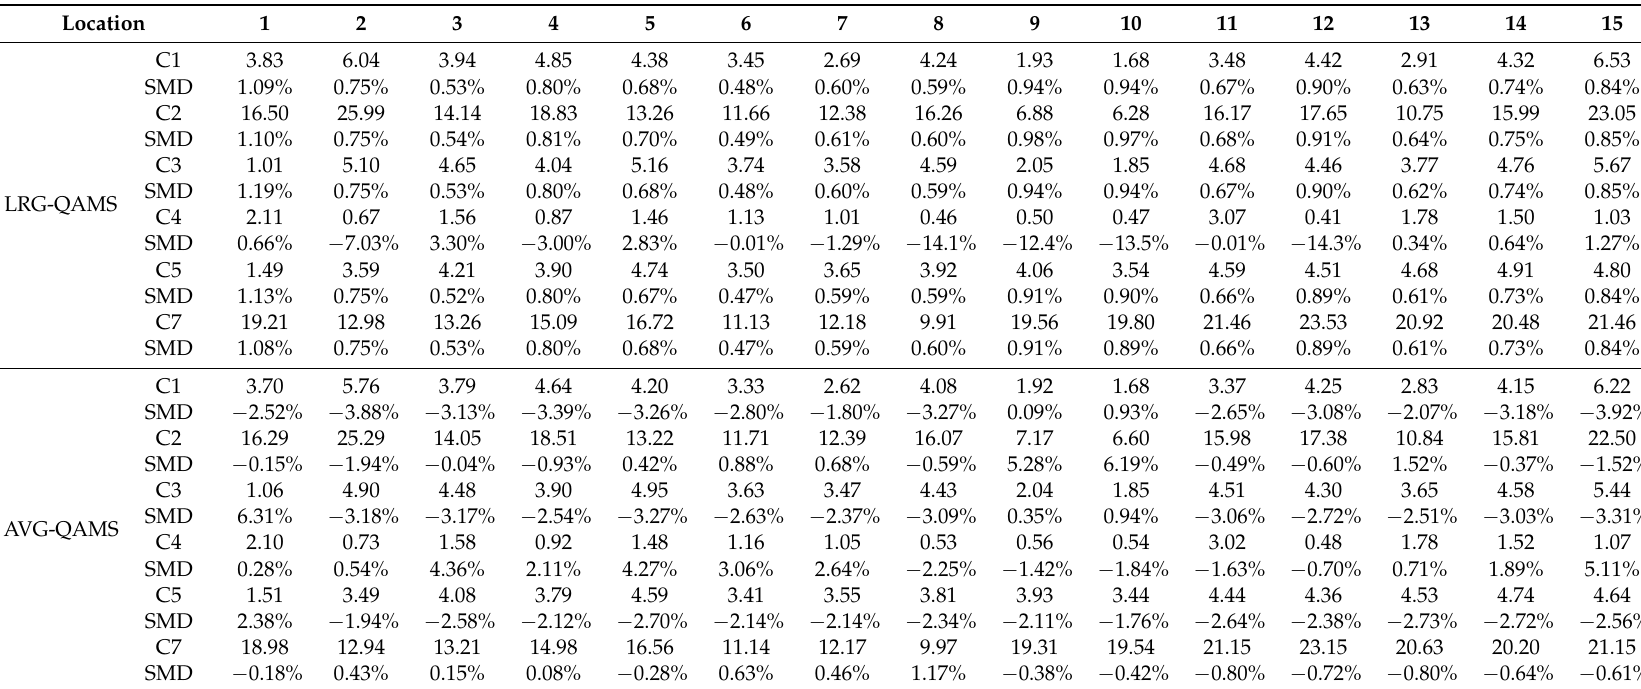
Table 6. The content of the marker components detected at 326 nm using both LRG-QAMS and AVG-QAMS method for data processing